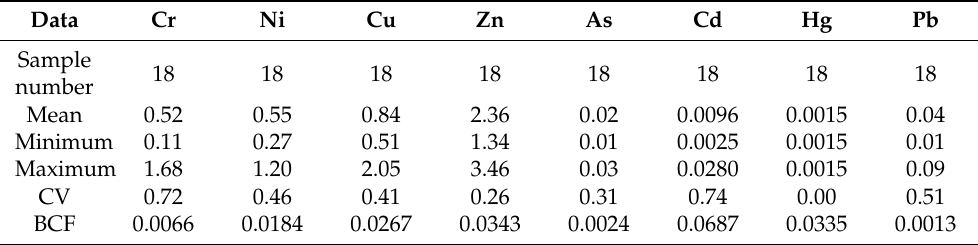
Table 6. Statistical characteristics of heavy metal contents in ginger